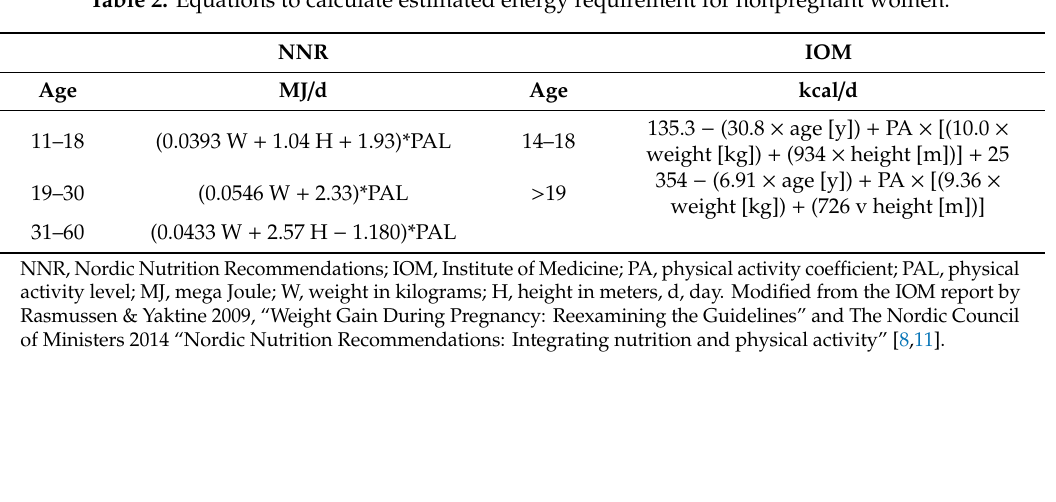
Table 2. Equations to calculate estimated energy requirement for nonpregnant